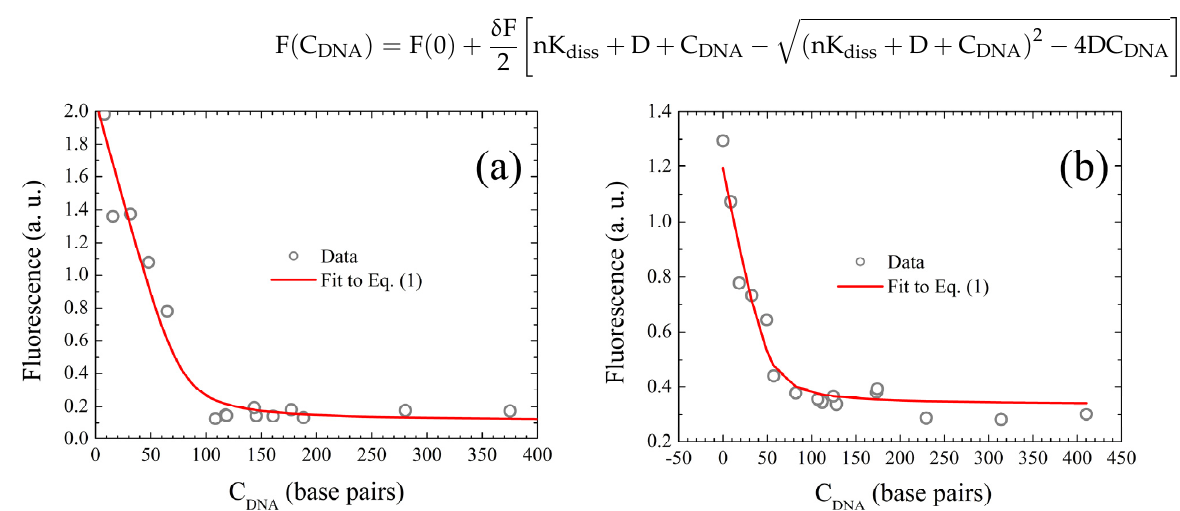
Figure 6. Binding isotherms of the binding of 1 to calf thymus DNA in 10 mM phosphate buffer. In order to dissolve the ligand in water, equal aliquots of concentrated stocks in organic solvents miscible with water were added to aqueous solutions of DNA in different concentrations. In panel ( a ), the organic solvent was DMSO and the final ligand concentration was 20 µM; in panel ( b ), DMF was used and the ligand was added to a final concentration of 15 µM. In both the experiments, the volume-to-volume concentration of organic solvent in phosphate buffer was 1:150. Table 4. Fitting parameters obtained by interpolation of the experimental binding isotherms of Fig- ure 6 with the independent binding site model, Equation (1).